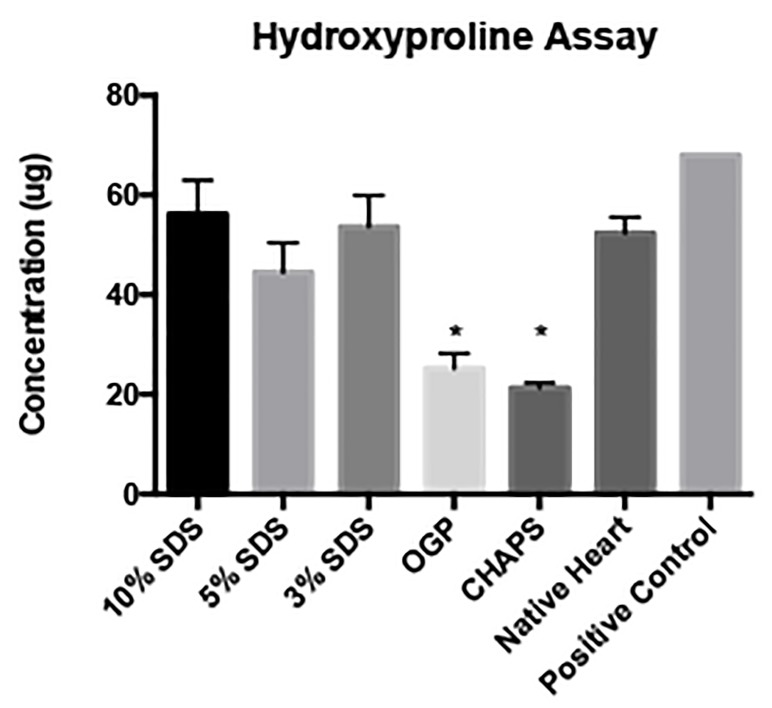
Hydroxyproline assay for collagen content. The collagen content of the hearts decellularized with SDS was similar to the native heart. OGP and CHAPS had significantly less collagen content than the native heart. n=3 for each group; * = p < 0.05; error bars expressed as SEM